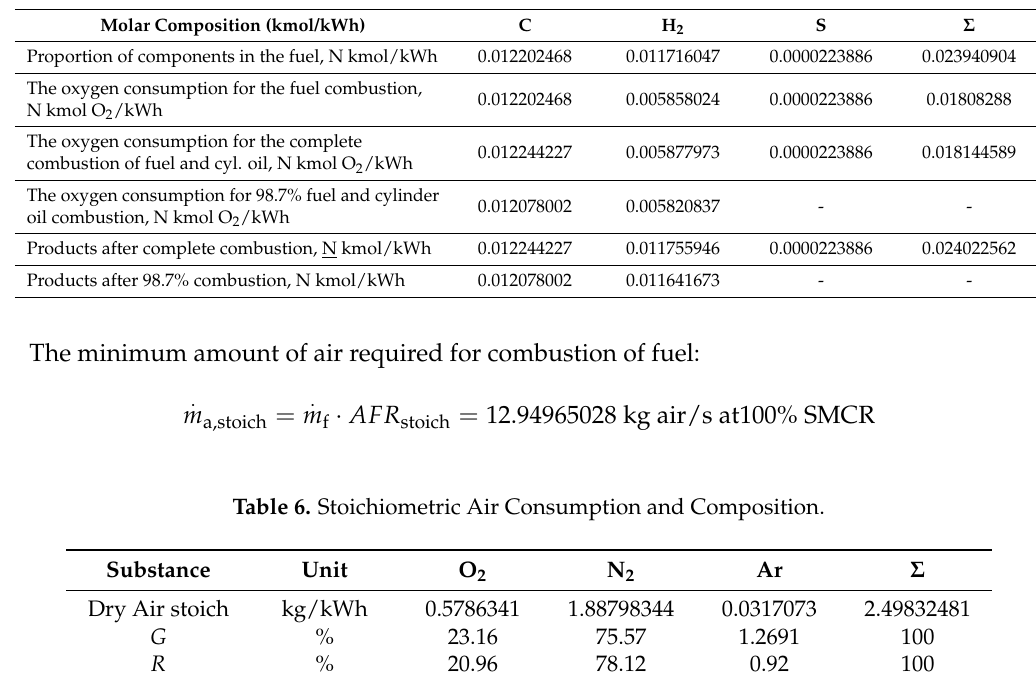
Figure 7. Air consumption ratio in the function of main engine load exh.gas